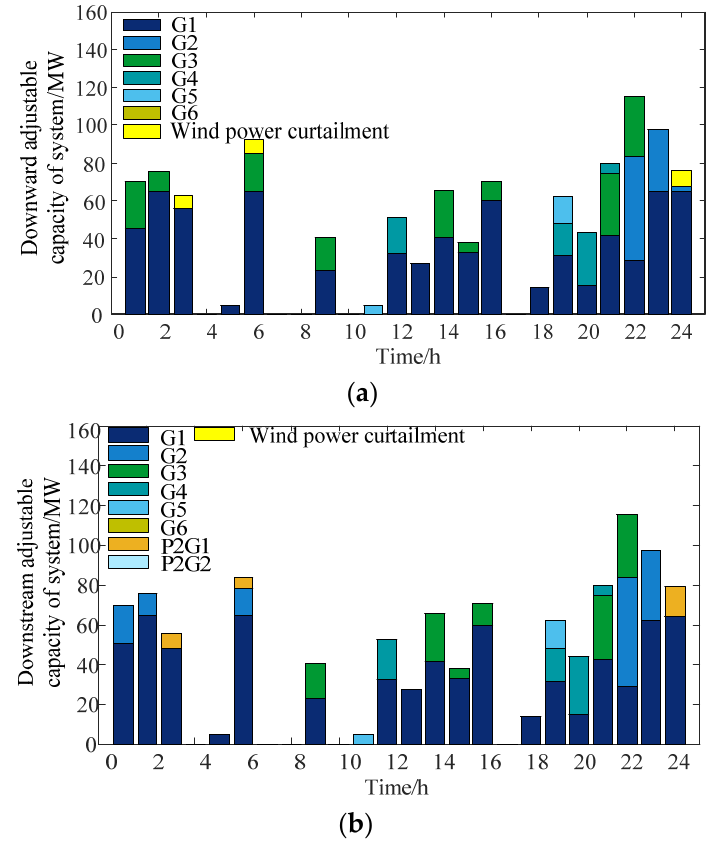
Figure 5. Power system downward adjustable capacity in different Cases: ( a ) Case1 and ( b )